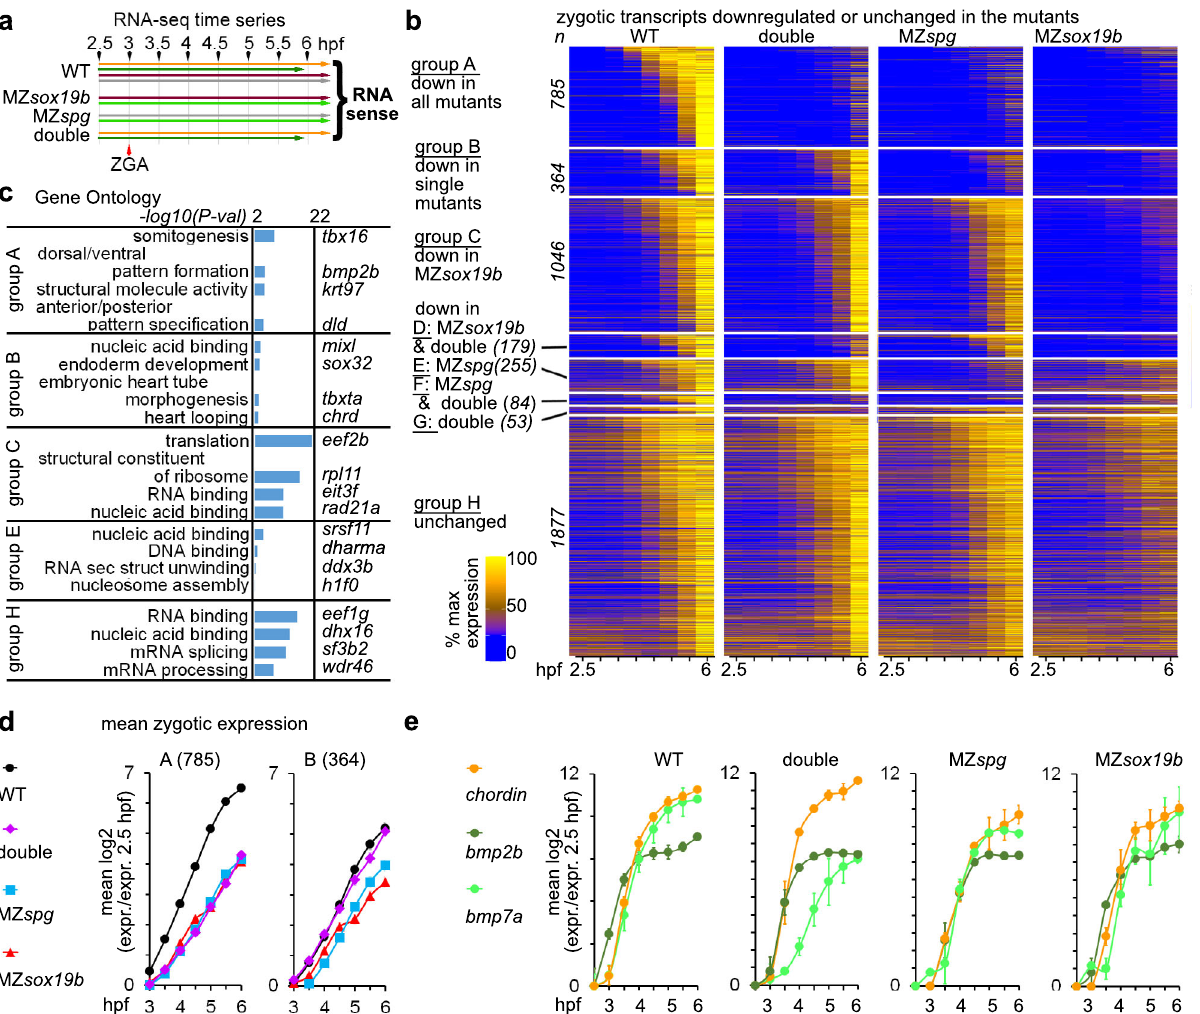
Fig. 3 Pou5f3 and Sox19b non-additively activate transcription. a Experimental setup: RNA-seq time series included eight time points, four replicates for the wild type, and two replicates for each MZ spg , MZ sox19b , and double mutant MZ sox19bspg (see Fig. S4a for the details). Time series, where material was collected in the same experiment, have the same color. b Heatmap of all 4643 zygotic transcripts in the indicated genotypes. 2766 transcripts were downregulated in the mutants (groups A – G),1877 transcripts were not (group H). Zygotic transcripts were sorted by ascending switch time and switch p -value in the wild type. n number of transcripts. c Enrichment in Gene Ontology terms (DAVID). Top four categories per group and example genes are shown. GO: enrichment for “ structural molecule activity ” in group A was due to the battery of eight keratins, activated by Klf17 in the epithelial layer 46 . d Non-additive (group A) and compensatory (group B) effects of Pou5f3 and Sox19b on the earliest zygotic transcription. Mean zygotic transcription pro fi les for the groups A and B, relative to 2.5 hpf. e Chordin/BMPs ratio is increased in the double mutant, but not in the single mutants throughout the time curve. Note that the transcription start of bmp2b and bmp7a , but not Chordin is delayed in the double mutant compared to the WT. In d , e : n (wt) = 4, n (MZ spg ) = 2, n (MZ sox19b ) = 2, n (double) = 2, where n is a number of biologically independent experiments. Data are presented as mean values ± SEM. Source data for b , d , and e are provided as a Source Data fi le. Source data for b – d are provided as Dataset